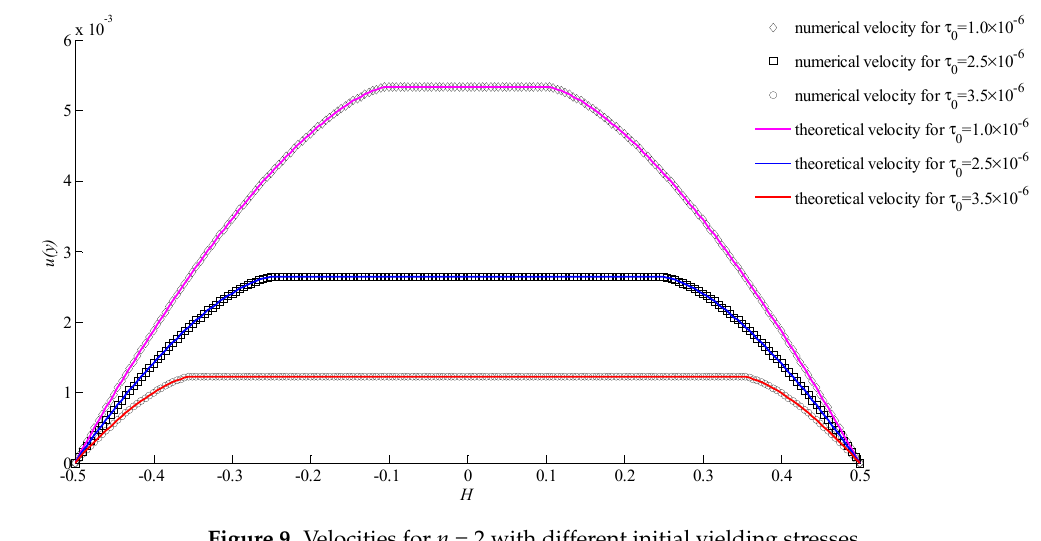
Figure 9. Velocities for n = 2 with different initial yielding stresses.